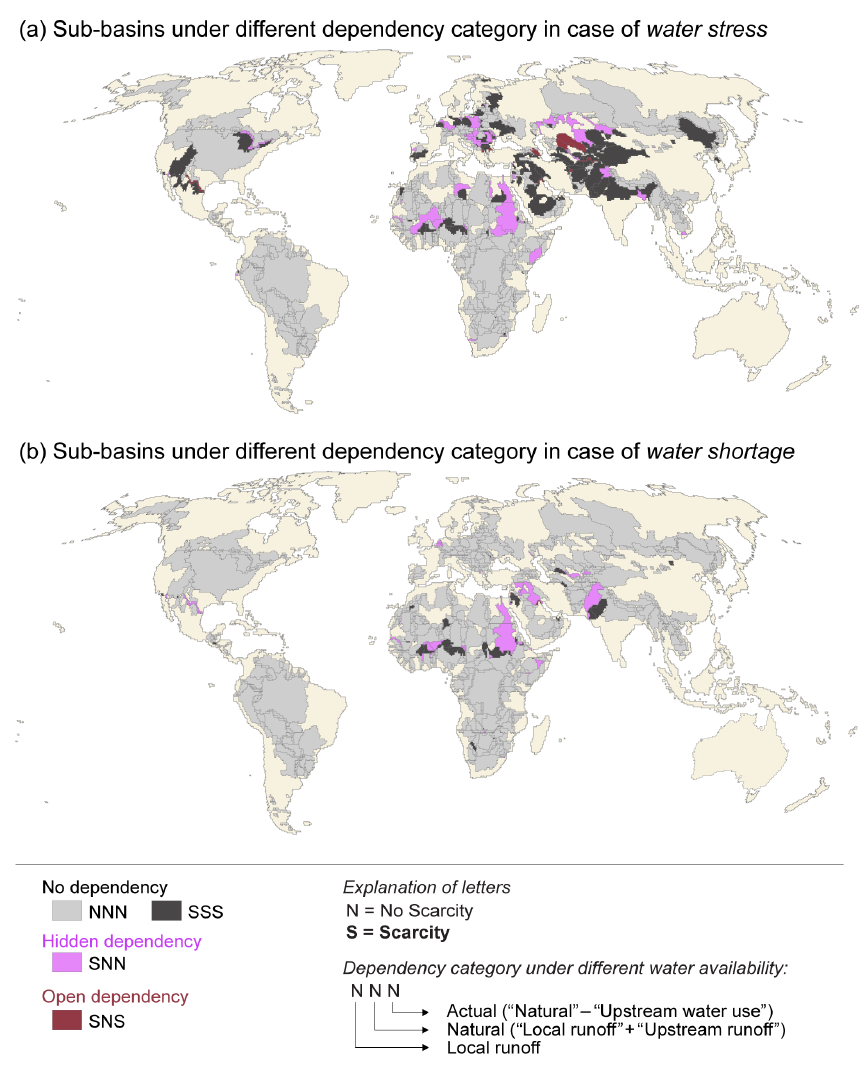
Figure 6. Dependency categories for each sub-basin area (SBA) for the year 2010 using (a) a water stress threshold value of 0.2 and (b) a water shortage threshold value of 1000m 3 yr − 1 cap − 1 . See definitions of dependency categories in Fig. 4 and definitions of key terminology in Table